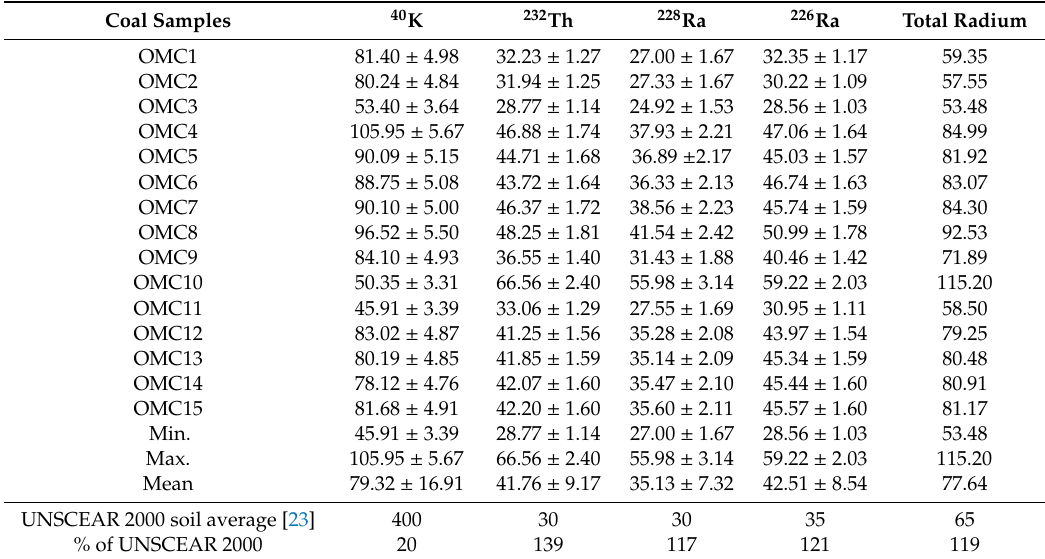
Table 1. Activity concentration of radionuclides in Omelewu coal samples (Bqkg − 1 ). Coal Samples 40